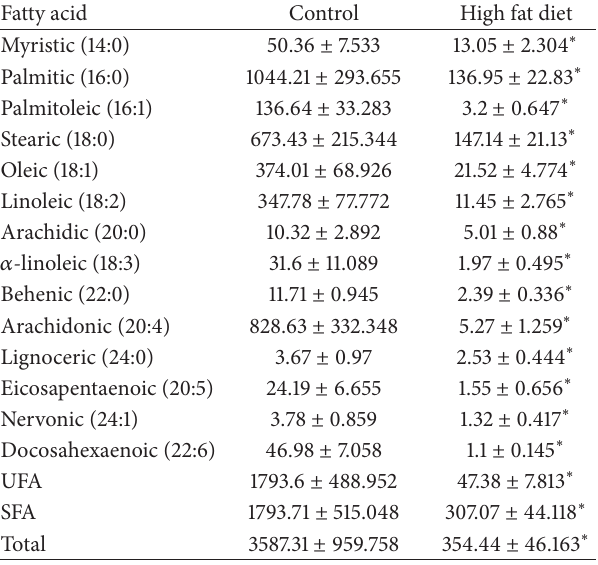
Table 5: Free fatty acids composition in the submandibular salivary glands